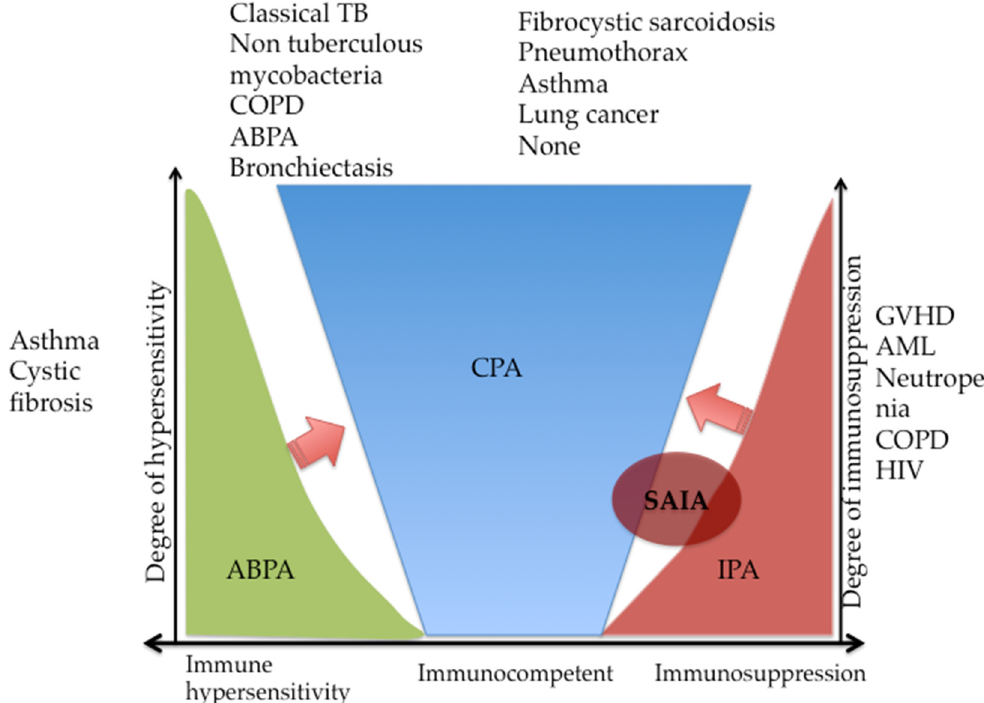
Figure 1. Spectrum of pulmonary aspergillosis based on the host-pathogen damage framework. ABPA, allergic bronchopulmonary aspergillosis; CPA, chronic pulmonary aspergillosis; IPA, invasive pulmonary aspergillosis; SAIA, subacute invasive pulmonary aspergillosis; GVHD, graft-versus-host disease; AML, acute myeloid leukaemia; COPD, chronic obstructive pulmonary disease; HIV, human immunodeficiency virus; TB, tuberculosis. ABPA and IPA can progress to CPA (arrows).